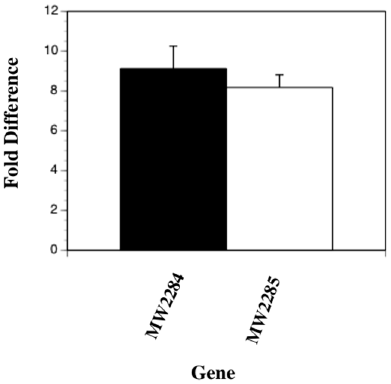
Figure 4. Quantitative reverse transcribed-polymerase chain reaction results of S. aureus srtA transcription in wild-type bacteria compared to MW2284 and MW2285 mutants. The data represents the mean + standard deviation from three separate runs.